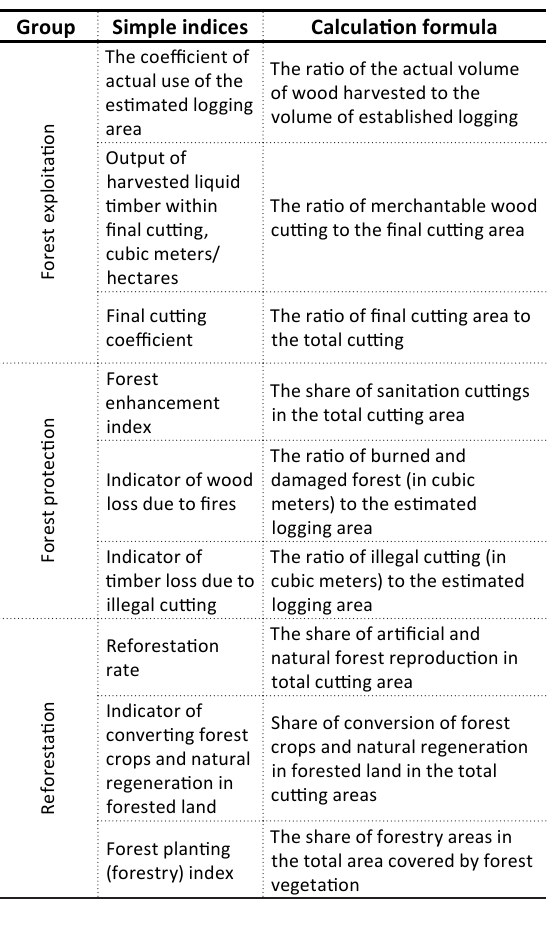
Table 1. Indices of forest resource security assessment